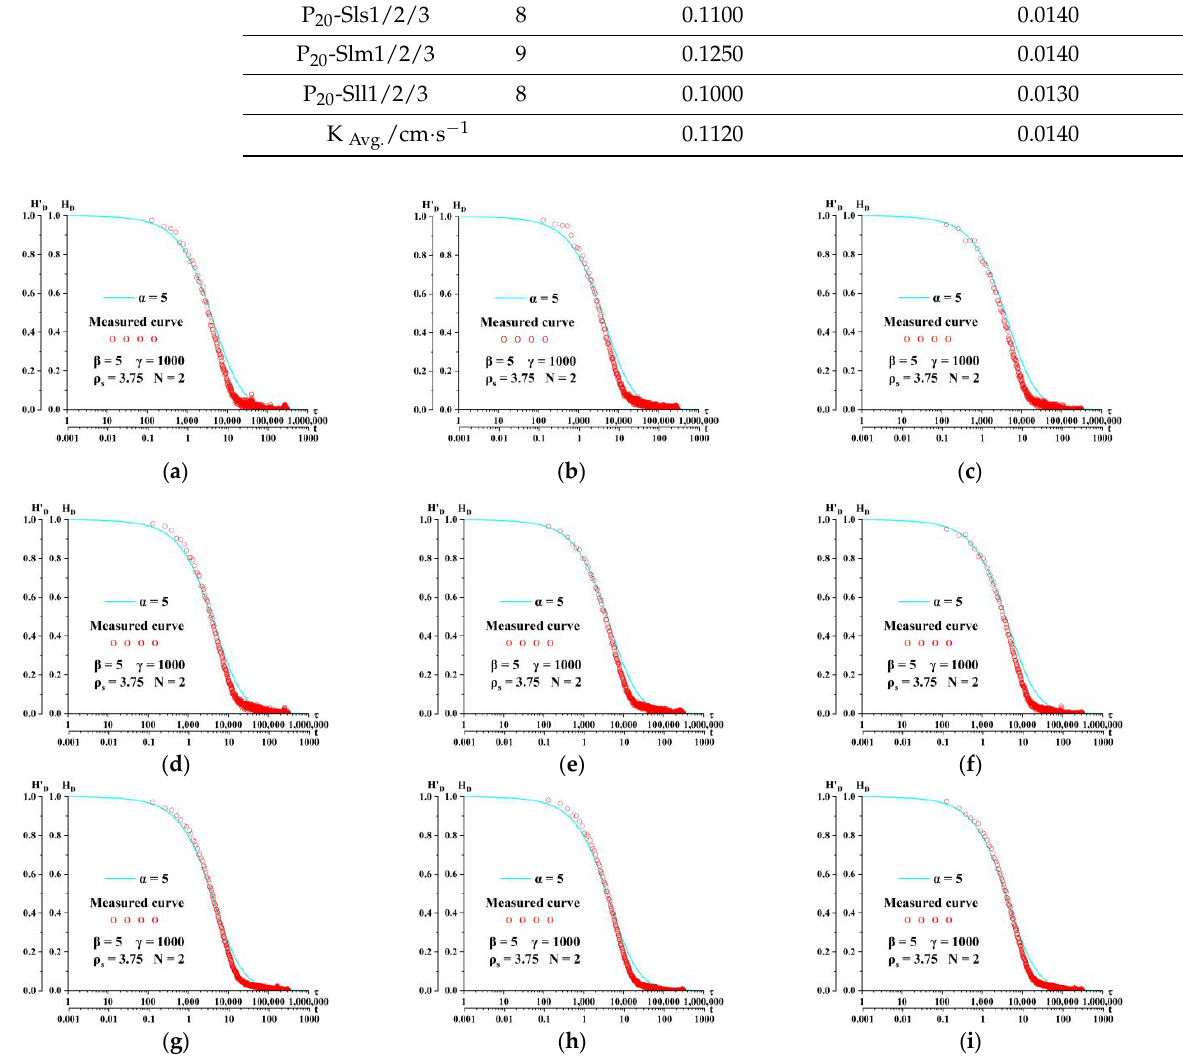
Figure 7. Curve fitting diagram between measured data from slug test and HWS model standard curve under the no well-skin conditions. ( a ) N-Sls1. ( b ) N-Sls2. ( c ) N-Sls3. ( d ) N-Slm1. ( e ) N-Slm2.